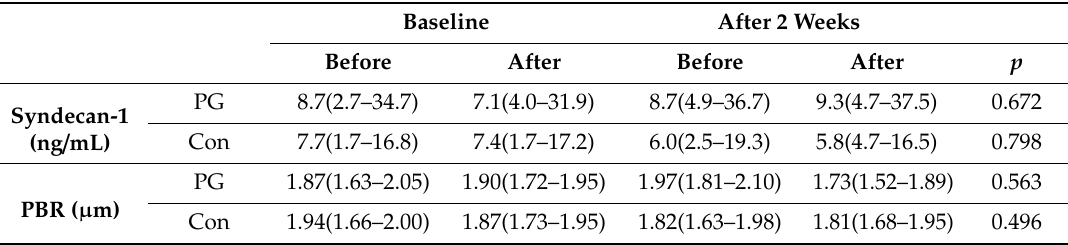
Table 2. Changes in glycocalyx parameters during the study period.